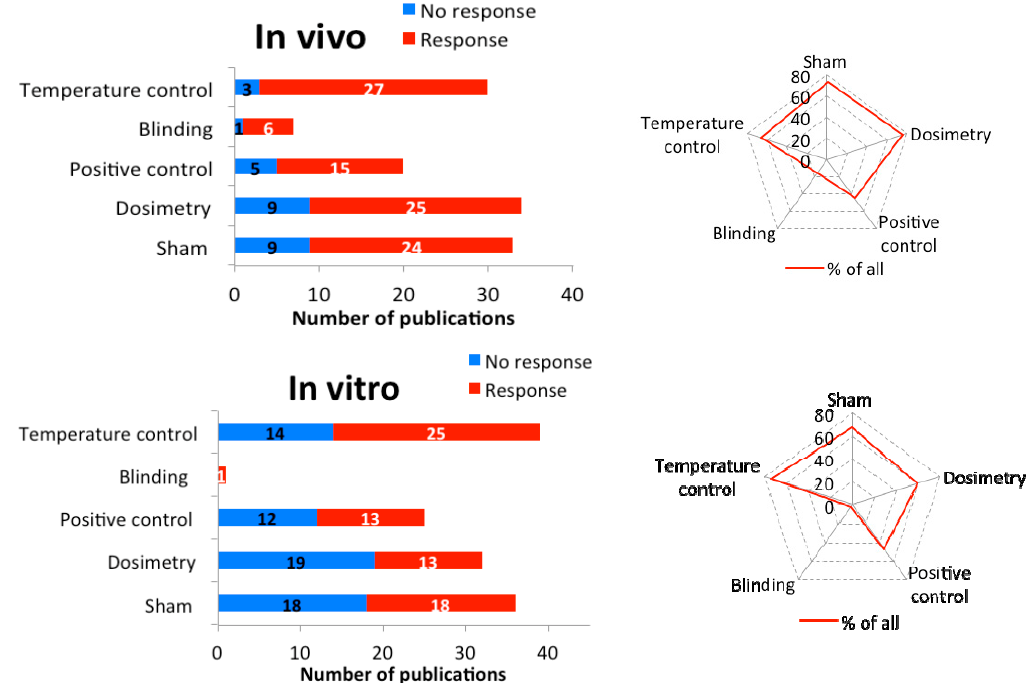
Figure 4. The quality of all publications: The number of in vivo (top) and in vitro (bottom) experiments (blue: no reaction, red: reaction) using the listed quality features (y-axis). The spider web shows the percentage of the quality characteristics in all examinations.